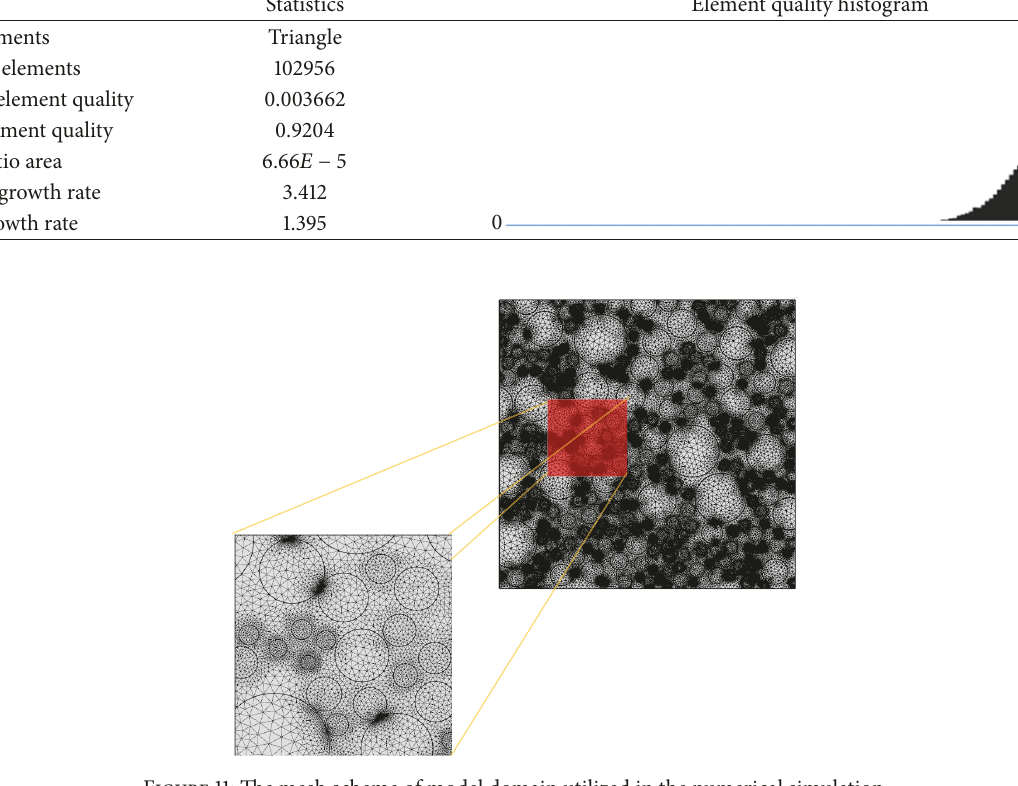
Figure 11: The mesh scheme of model domain utilized in the numerical simulation.